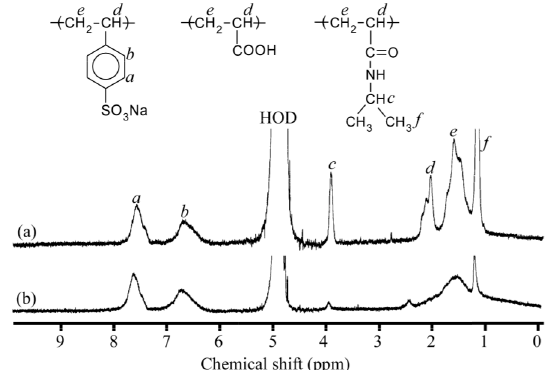
Figure 2. 1 H NMR spectra and peak assignment of the mixture of PNaSS 58 – b – PAA 125 and PNaSS 58 – b – PNIPAM 115 in D 2 O containing 0.1 M NaCl at ( a ) pH 10 and ( b ) pH 3.